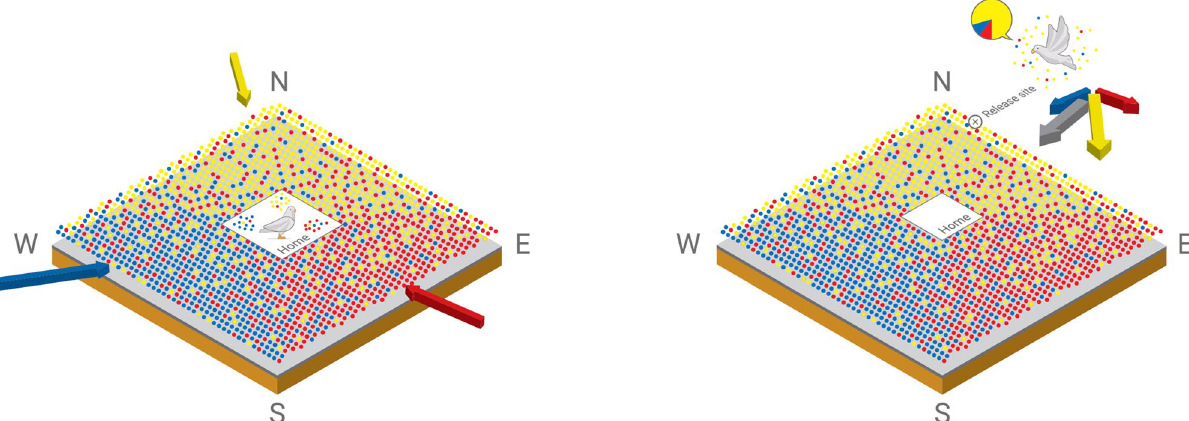
Figure 7. Over a period of months, fledgling pigeons learn to associate odours with wind directions and time of day. The coloured dots symbolize these regional scale odour gradients and the olfactory map envisaged by the pigeon (left panel). When pigeons are displaced to a release site (marked with a cross) the pigeon is exposed to the local odour spectrum (right panel). This compares to the odour spectrum experienced at home and orientates accordingly homeward. For instance a pigeon released in the yellow area will orient roughly south (yellow scent is higher at release point than at home and the pigeon knows this scent comes from the North).